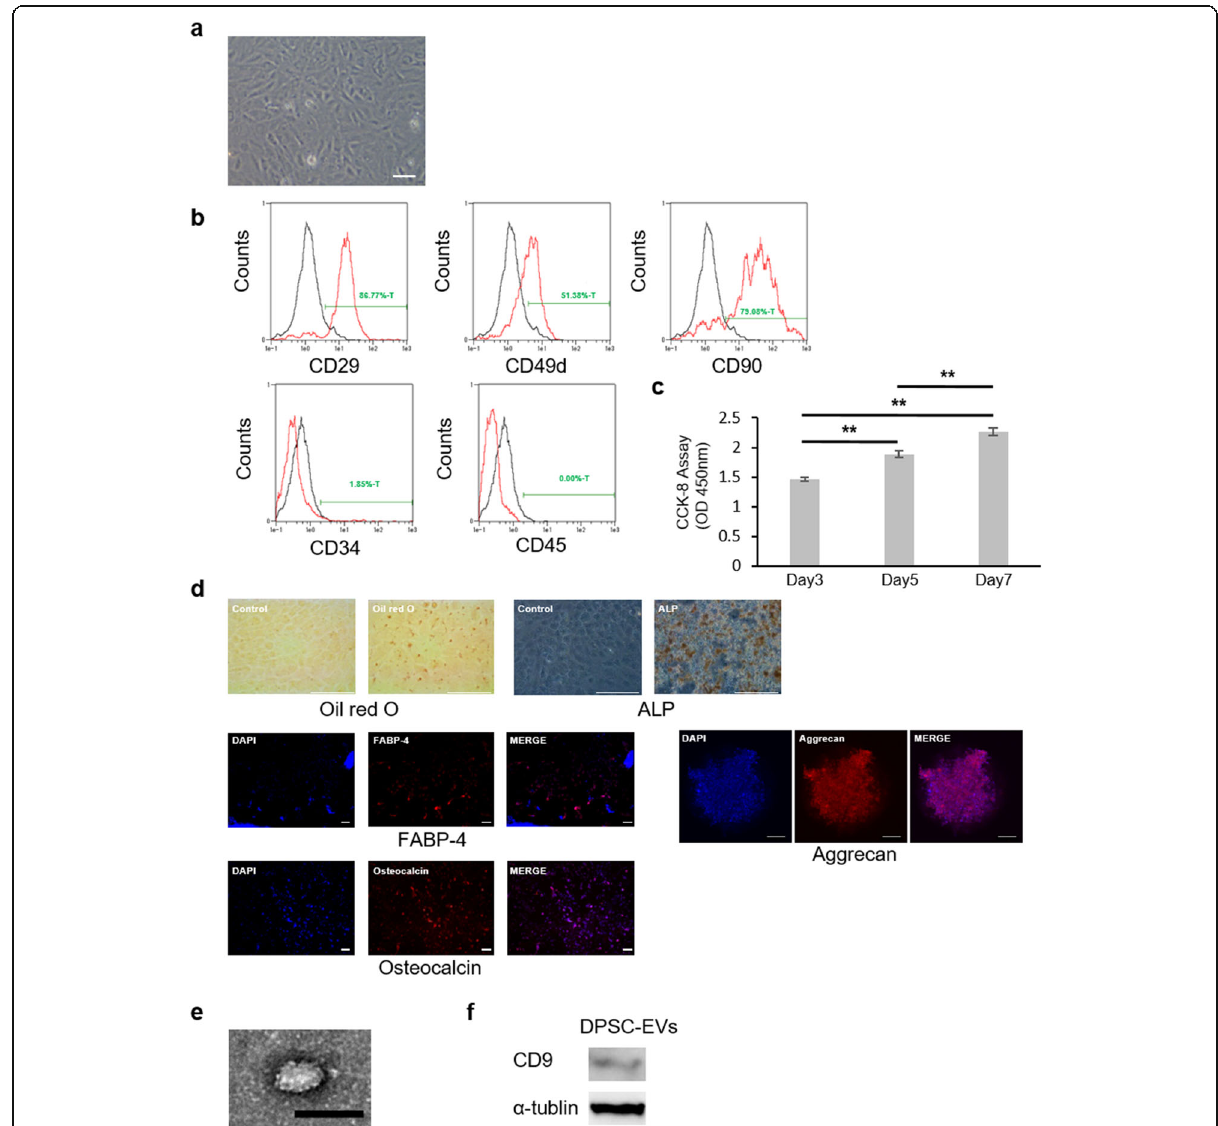
Fig. 2 Characterization of DPSCs and DPSC-EVs. a Cultured DPSCs observed under a phase contrast microscope. Bars = 100 μ m. b Flow cytometric histograms of DPSCs. The expression of the cell surface markers CD29, CD34, CD45, CD49d, and CD90 was analyzed. Black line: isotype control. Red line: stained with specific antibodies. c The proliferation of DPSCs was assessed by the CCK-8 assay on day 3, day 5, and day 7. Results are expressed as means ± SEM ( n = 8). d The capacity of DPSCs to differentiate into adipocytes, osteoblasts and chondrocytes was assessed by Oil red O, ALP, FABP-4, osteocalcin and aggrecan staining. Bars = 100 μ m. e DPSC-EV morphology observed using TEM. Bars = 100 nm. f Western blot analysis of the expression of the EV surface marker CD9 in